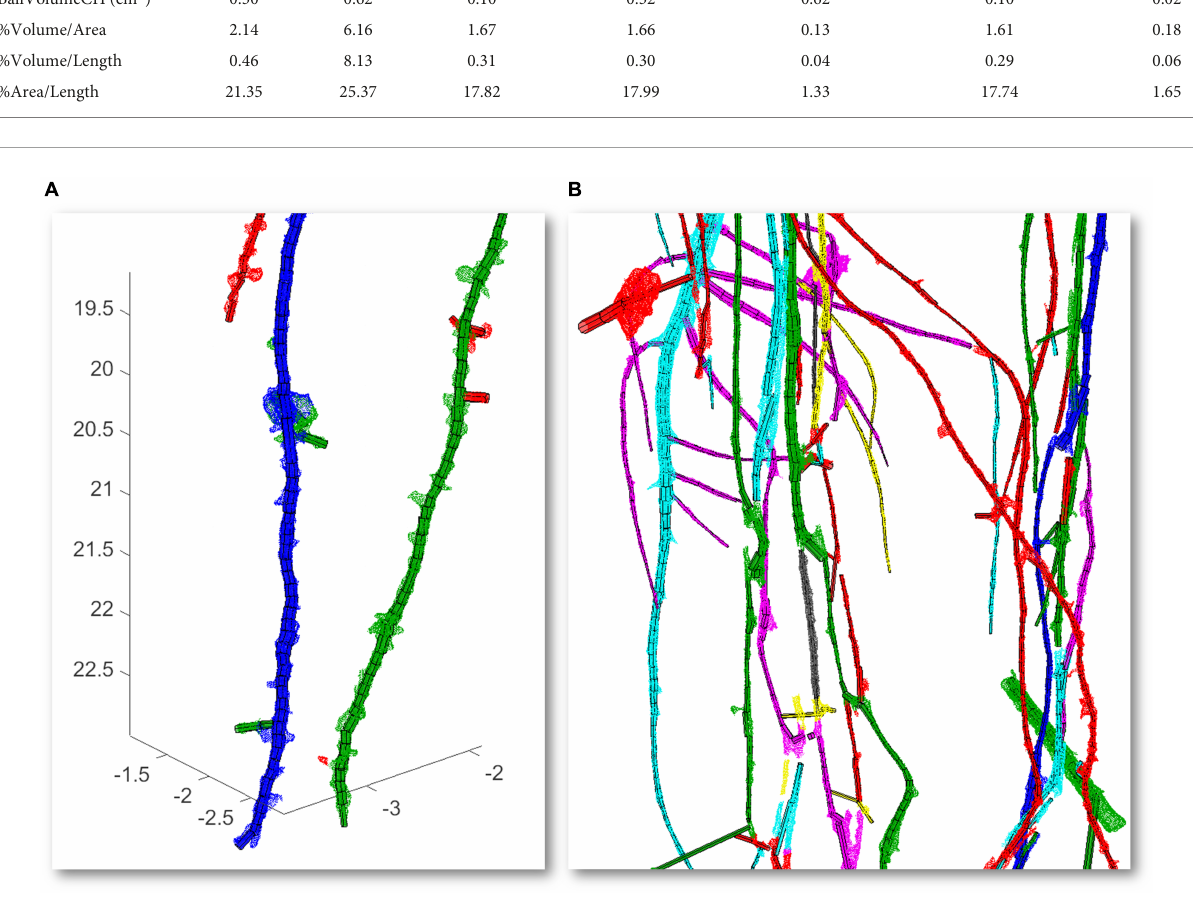
FIGURE5 Overlapping between the cylindrical models represented with polyhedrons and the computed tomography (CT) scan scale factor (SF of 0.1) represented with dense points, both in colors depending on the ramification order: zoom with volume discrepancies detected lateral roots (axes in cm) (A) and zoom highlighted the complexity of the root (B)